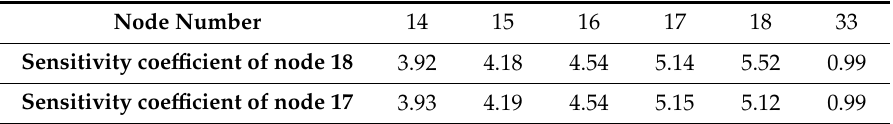
Table 4. Sensitivity coe ffi cients of node 17 and